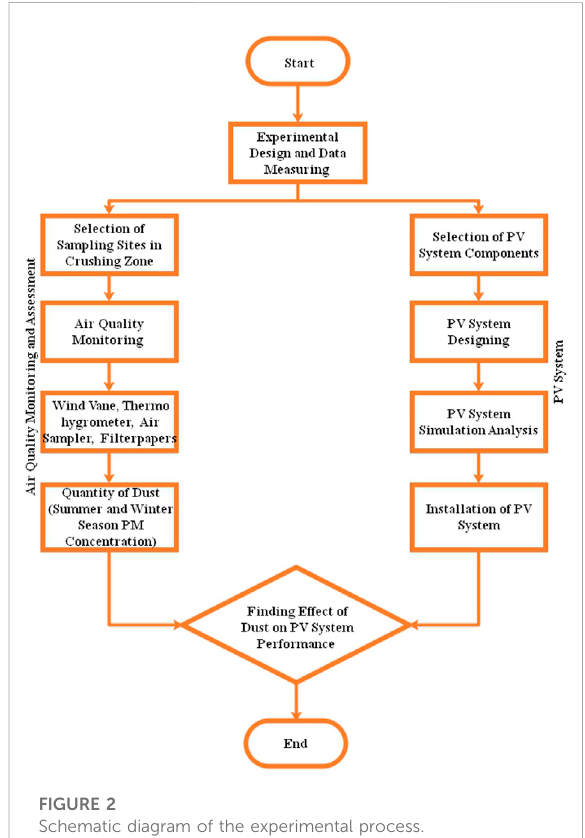
FIGURE 2 Schematic diagram of the experimental